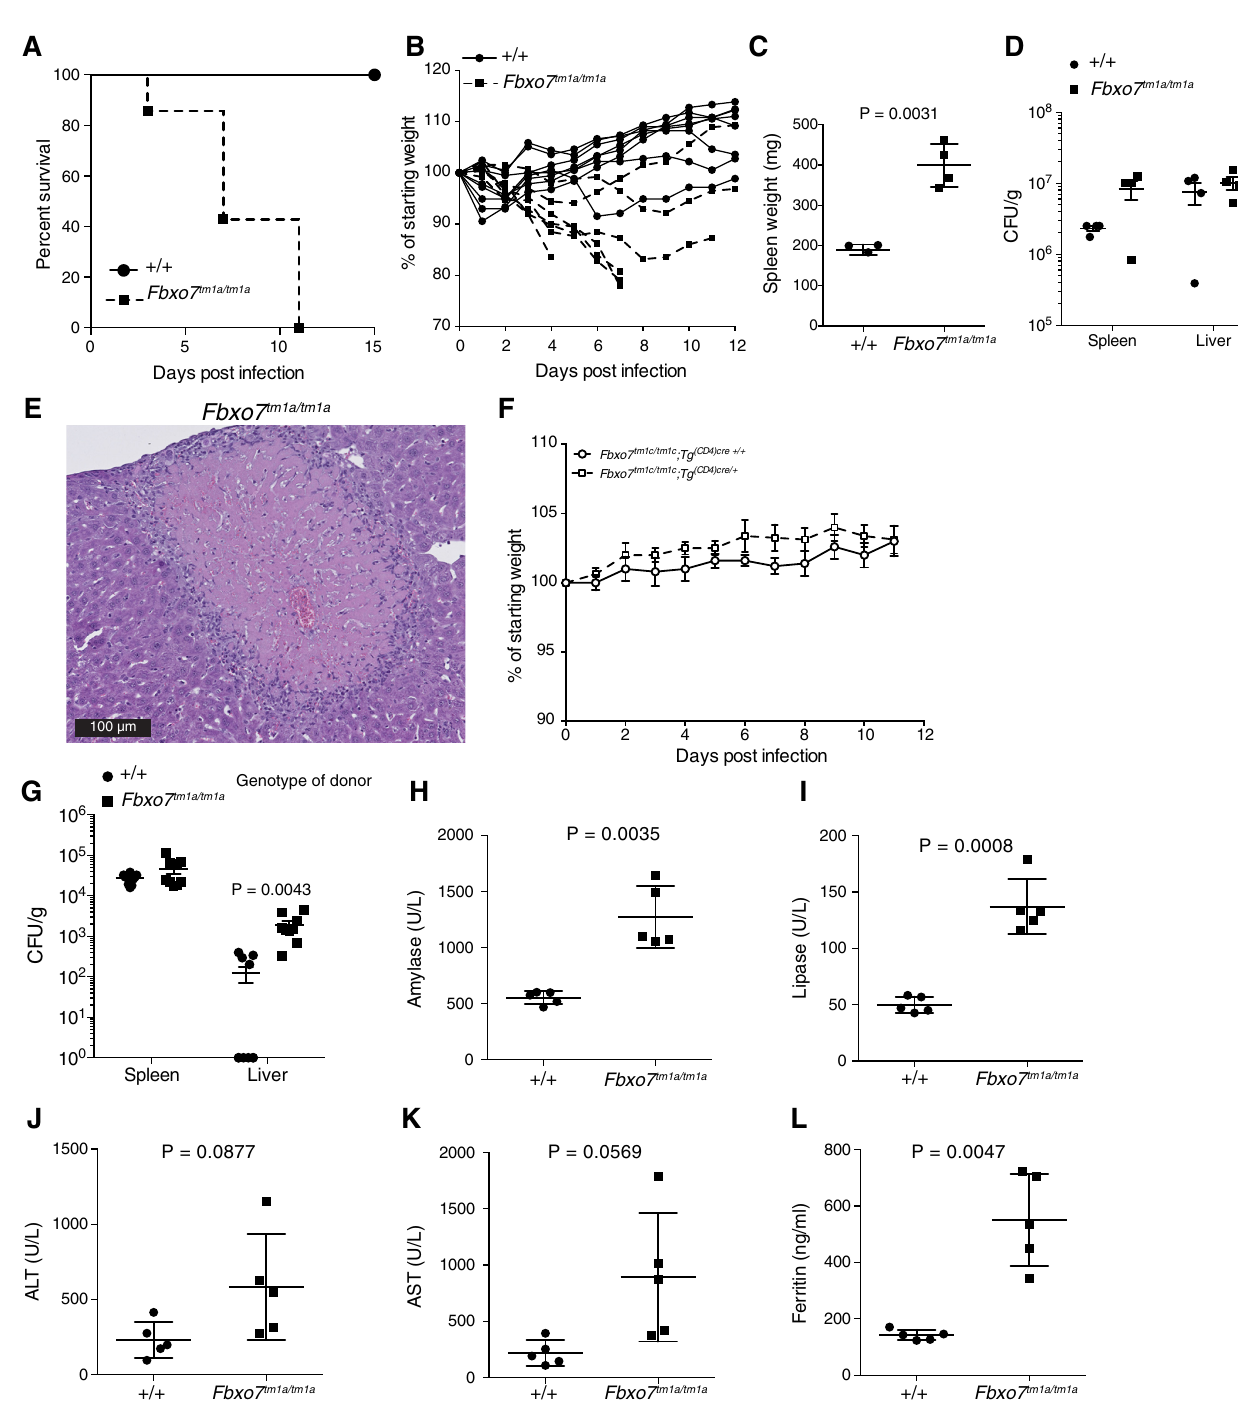
Fig 5. Increased morbidity after infection of Fbxo7 tm1a mice with Salmonella typhimurium. (A) Survival curve of 4 female and 4 male Fbxo7 +/+ mice and 3 female and 4 male Fbxo7 tm1a/tm1a mice. (B) body weight changes during the course of infection from mice shown in panel A. (C) spleen weights at day 6 post Salmonella infection of male mice, with 3 Fbxo7 +/+ and 4 Fbxo7 tm1a/tm1a mice. (D) spleen and liver Salmonella counts at day 6 post infection of male mice, with 3 Fbxo7 +/+ and 4 Fbxo7 tm1a/tm1a mice. (E) histopathological image of liver showing a typical necro-inflammatory focus with an oval nodule consisting of eosinophilic necrotic hepatocytes surrounded by a rim of inflammatory cells that are predominantly neutrophil leucocytes, from a male Fbxo7 tm1a/tm1a mouse at day 6. (F) body weight changes during course of infection for male mice deficient for Fbxo7 in T cells ( Fbxo7 tm1c/tm1c ;CD4-Cre + 8 mice) and littermate